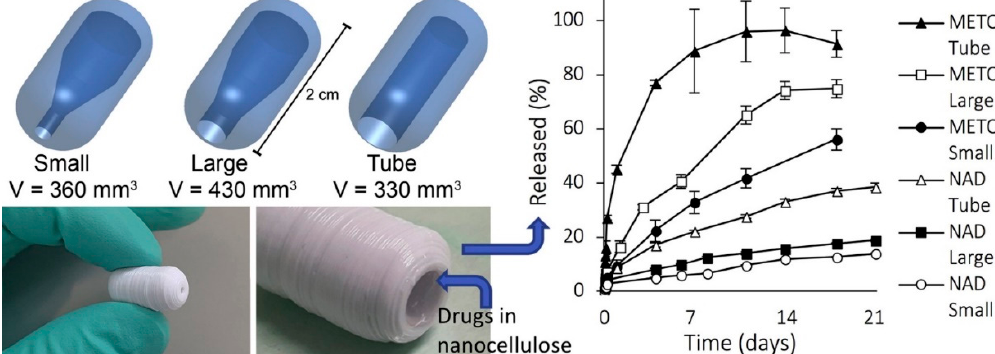
Figure 10. Computer-aided designs and 3D printed PLA capsules ( left ). The tubes were filled with a hydrogel formulation that can sustain drug release after 3 weeks ( right ). The drugs were metoprolol (METO) and nadolol (NAD); small, tube, and large denote different PLA tube sizes. Reproduced from [202] with permission.